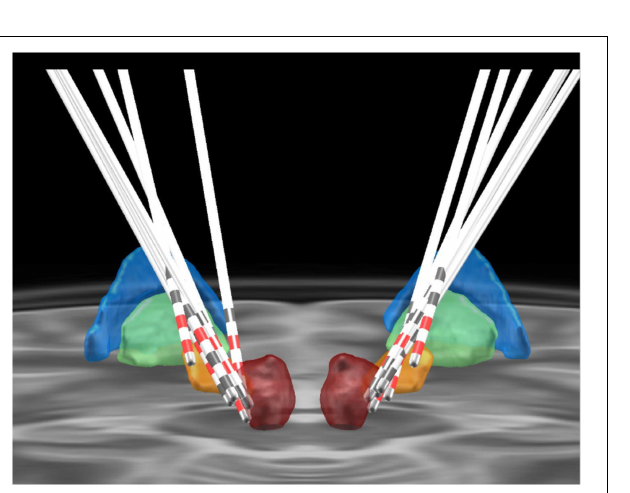
FIGURE 2 | Positioning of the electrodes for posterior subthalamic area-deep brain stimulation. The colored areas represent different anatomical structures (blue, globus pallidus externus; green, globus pallidus internus; orange, subthalamic nucleus; red, red